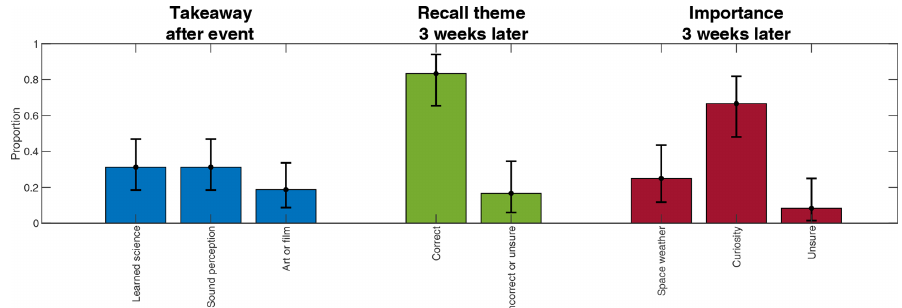
Figure 8. Summary statistics of evaluation data following SSFX